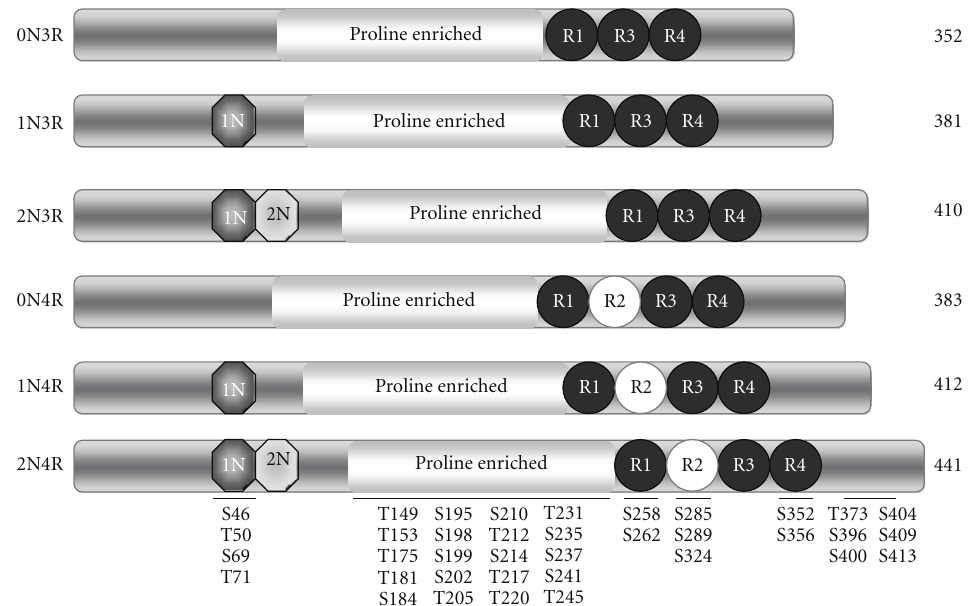
Figure 1: Tau isoforms in the human CNS and identified GSK-3 phosphorylation sites. The diagram illustrates the six isoforms of tau present in the human CNS. The longest tau isoform includes alternatively spliced exons 2, 3, and 10. Exons 2 and 3 encode two short amino acid inserts near the N-terminus of the molecule (1N and 2N, respectively). Exclusion of exons 2 and 3 gives rise to 0N tau isoforms, inclusion of exon 2 produces 1N tau isoforms, and inclusion of exons 2 and 3 results in the expression of 2N tau isoforms. Exon 10 encodes an additional microtubule-binding repeat domain (R2) that is present in 4R, but absent from 3R, tau isoforms. The number of amino acids in each tau isoform is indicated on the right. The centre of the molecule comprises a proline-enriched region that harbours the majority of the identified GSK-3 phosphorylation sites in 2N4R tau. Serine (S) and threonine (T) residues that have been identified as being phosphorylated by GSK-3 in vitro are indicated